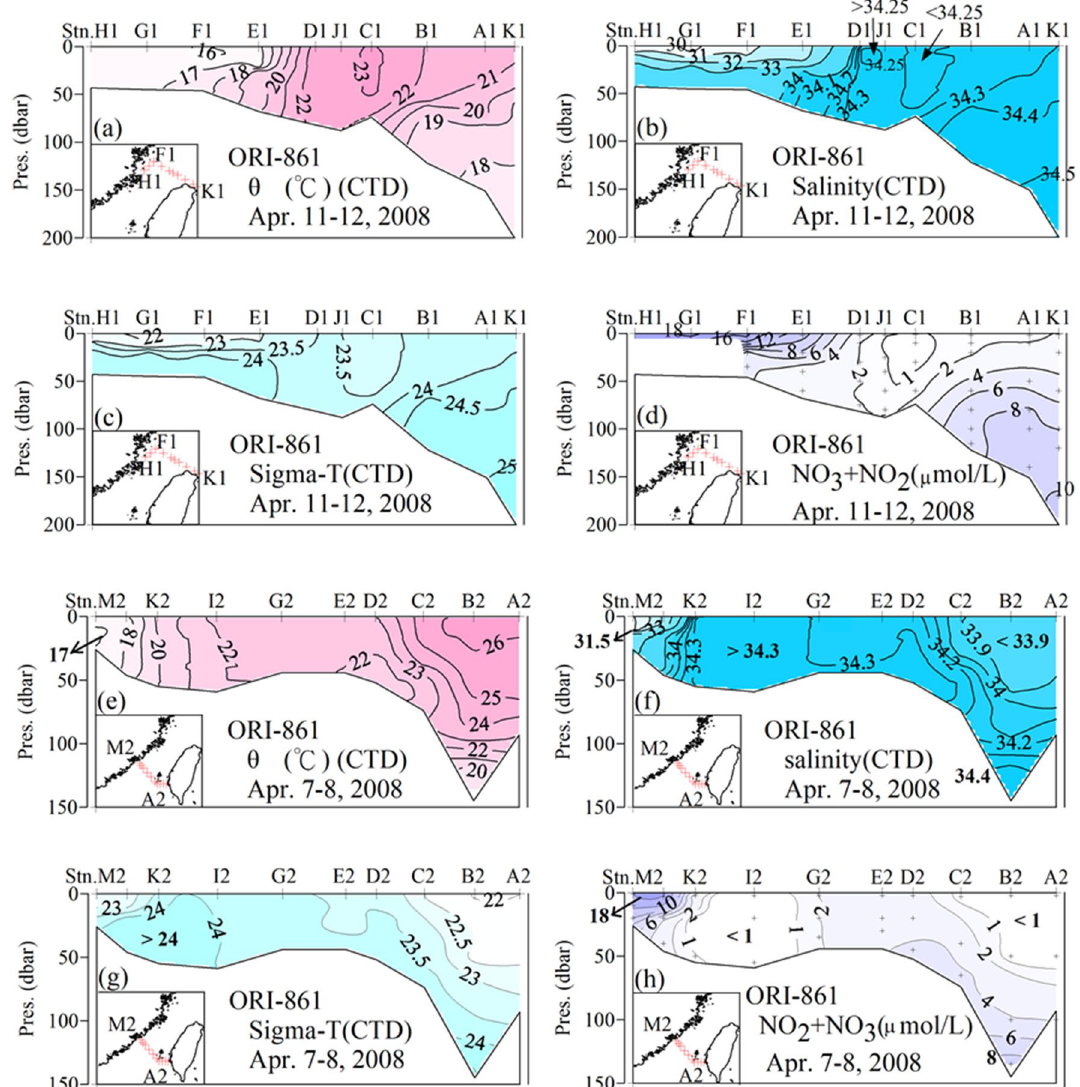
Figure 2. Cross section of ( a , e ) θ, ( b , f ) S, ( c , g ) σ t and ( d , h ) NO 3 + NO 2 in the southwestern East China Sea and southern Taiwan Strait (map generated by Surfer version 8.0; https ://www.golde nsoft ware.com/produ cts/surfe